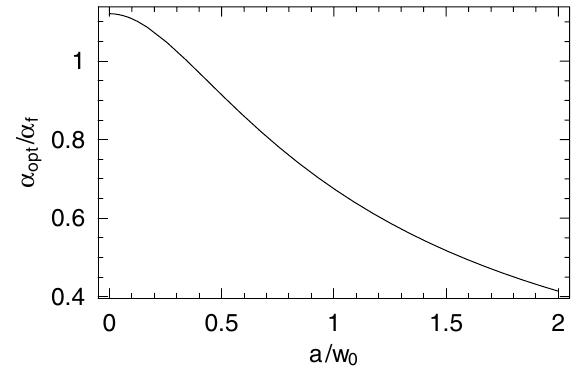
FIG. 2. The optimal tilt angle as a function of the hole radius for the tilted Gaussian laser beam.